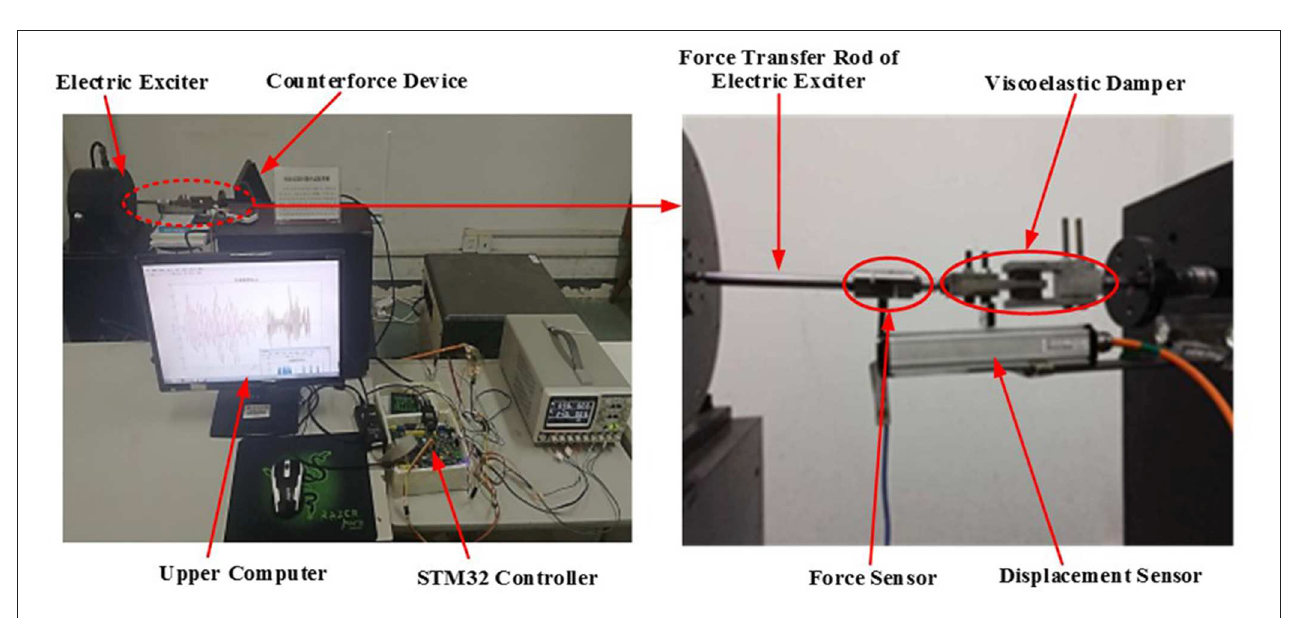
FIGURE 5 | The test device of the hybrid test